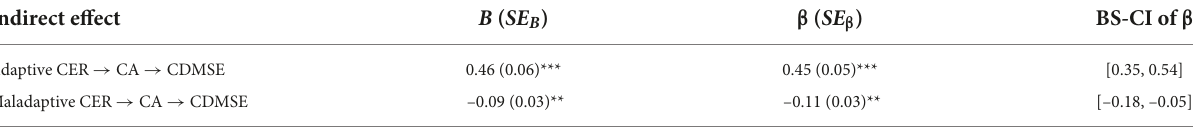
TABLE 5 Path coefficients and bootstrapping confidence intervals of indirect